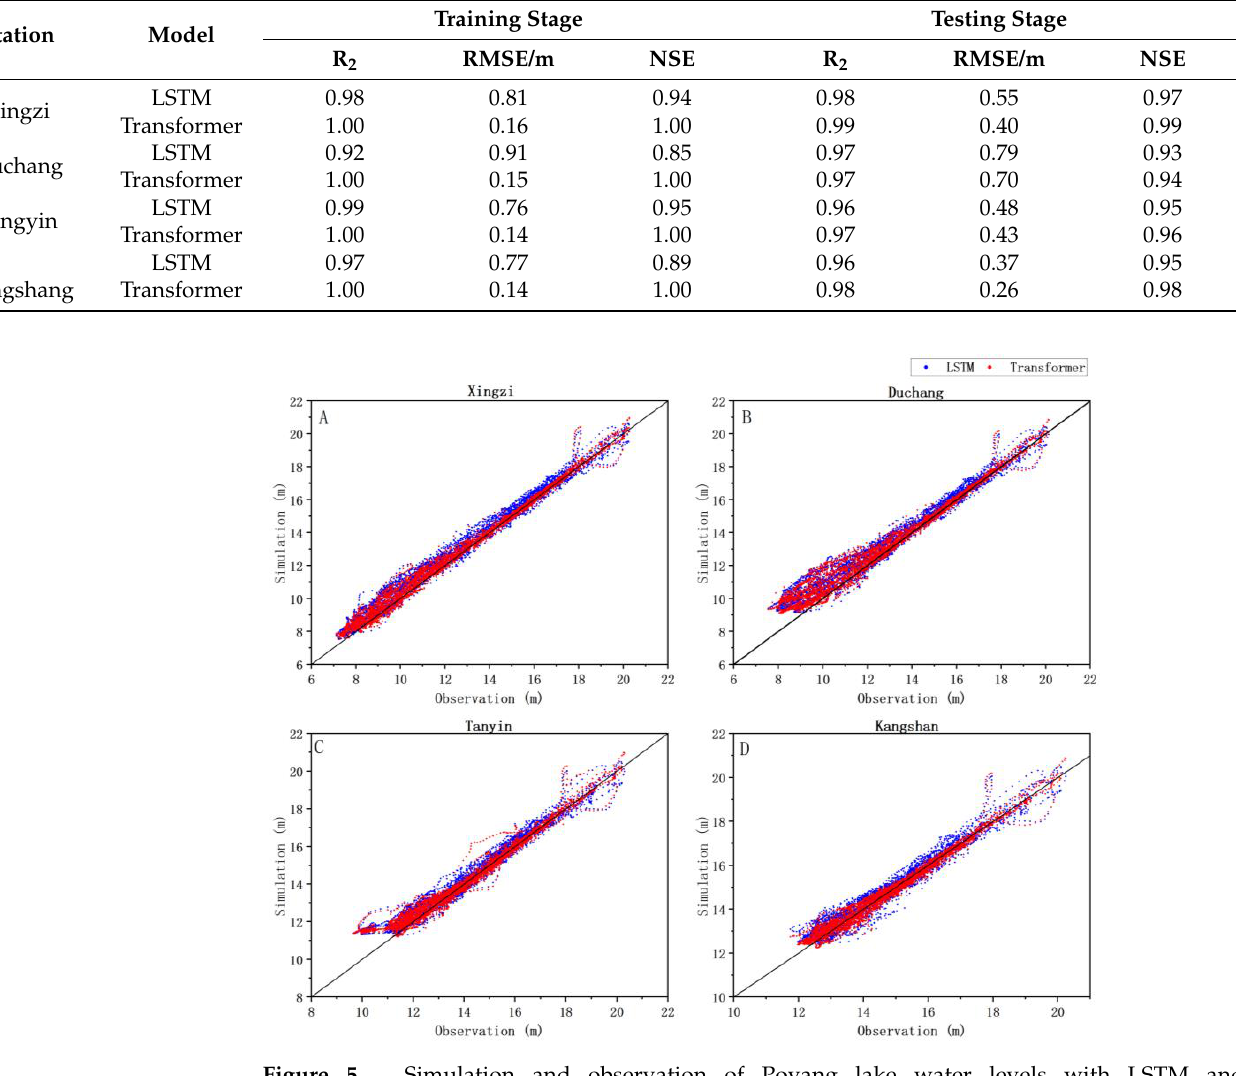
Figure 5. Simulation and observation of Poyang lake water levels with LSTM and Transformer mod- els.